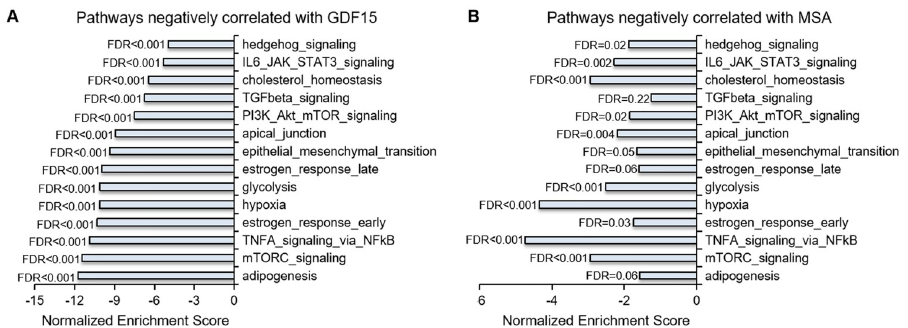
Fig 5. Same pathways are affected GDF15 and MSA. GSEA was conducted on the combined RNA-seq data of 500 TCGA primary prostate cancer (primary) samples and 159 metastatic CRPC (mCRPC) samples from the SU2C, PROMOTE, and Beltran cohorts and the microarray data from PC-3 cells treated with or without MSA. The same pathways that are negatively correlated with GDF15 levels in the combined RNA-seq data (A) are negatively correlated with MSA treatment in the PC-3-MSA microarray dataset (B) . FDR < 0.25 is considered significant.